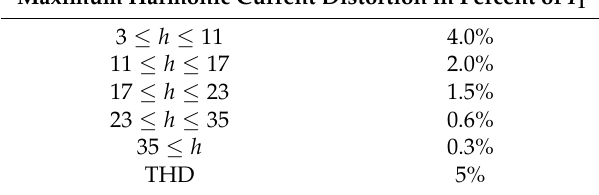
Table 1. Current distortion limits for systems rated 120 V through 69 kV. (THD: total harmonics distortion.). Maximum Harmonic Current Distortion in Percent of I 1